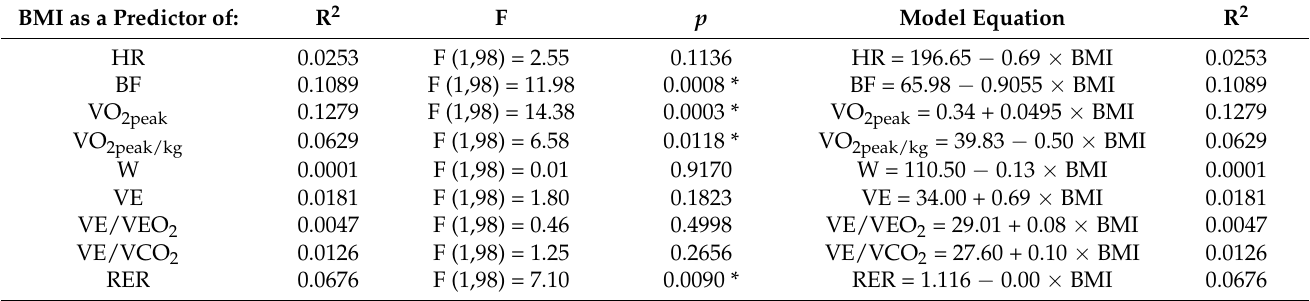
Table 6. Linear regression.